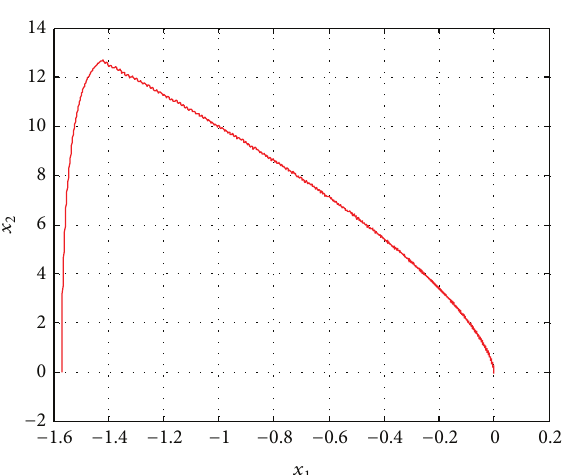
Figure 2: Sliding variable ( 𝑠 ).